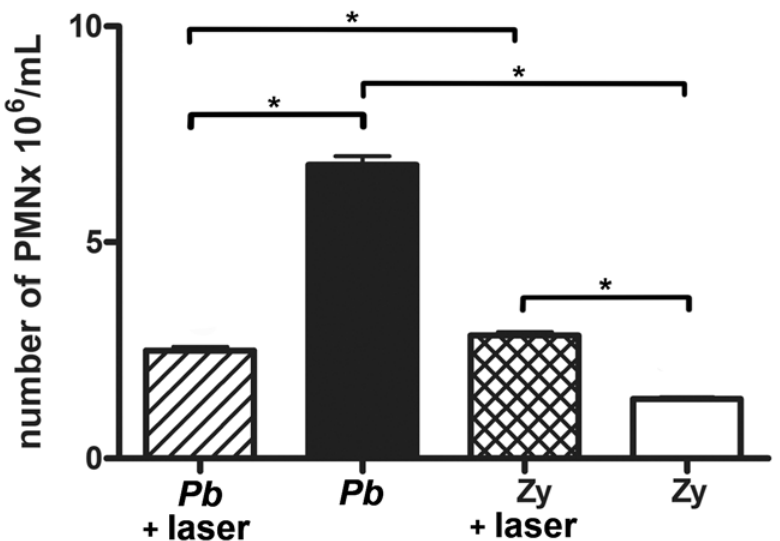
Fig 2. Extraction of PMN from the air-pouch. Absolute number of PMN at extraction time for both irradiated and non-irradiated mice of Pb and Zymosan (Zy) groups; p = 0.0001 ( * ) between non-irradiated and irradiated PMN of Pb groups; p = 0.0001 ( * ) between non-irradiated and irradiated PMN of Zy groups; p = 0.0001 ( * ) between PMN from non-irradiated Pb and Zy groups; p = 0.0399 ( * ) between PMN from irradiated Pb and Zy